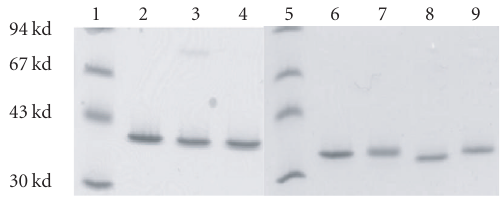
Figure 4: Control of homogeneity and absence of significant dimer- ization in nonreducing conditions by 3–8% (w/v) SDS-PAGE of 200 ng of each mutated protein: lane 1: molecular ladder, lane 2: LukF-PV, lane 3: LukF-PV T5C-T21C oxidized (ox), lane 4: LukF- PV S8C-K20Cox, lane 5: molecular ladder, lane 6: LukS-PV, lane 7: LukS-PV-1C-R16Cox, lane 8: LukS-PV D1C-R16Cox, lane 9: LukS- PV